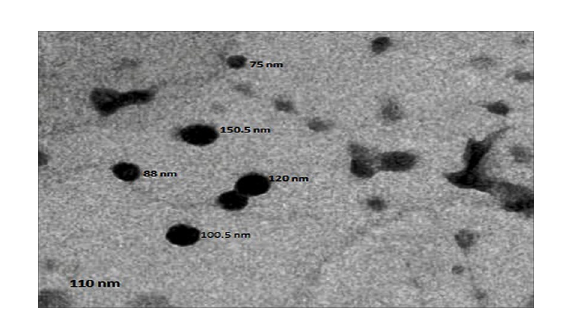
FIGURE6 TEM image of optimized RT-SLN